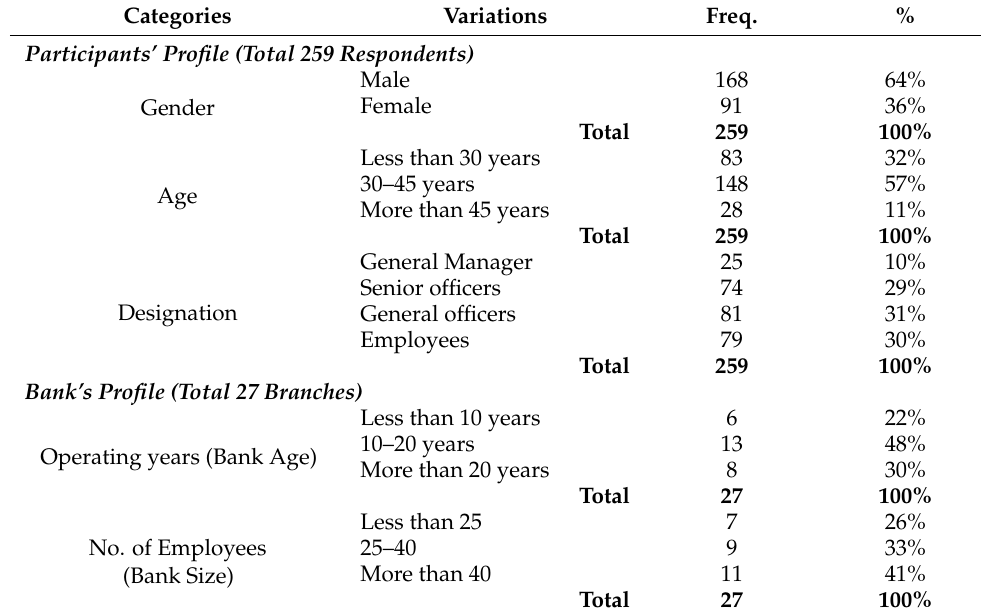
Table 1. Profiles of bank and